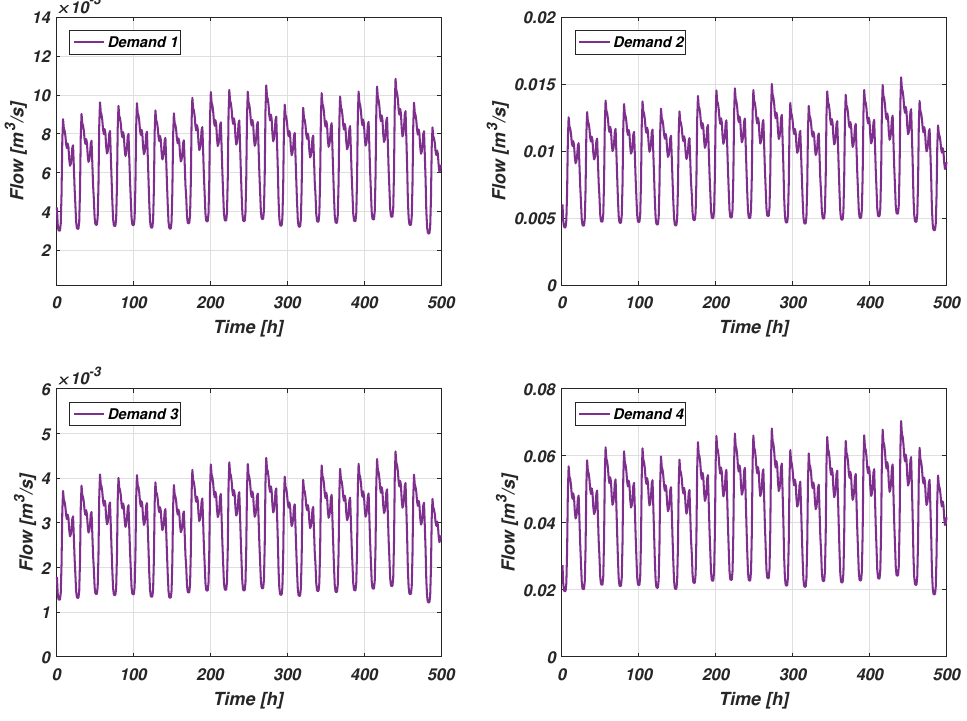
Figure 3. Drinking water demand for the three tanks example. Table 1. Success minimal paths of the water transport network of Barcelona (three tanks).